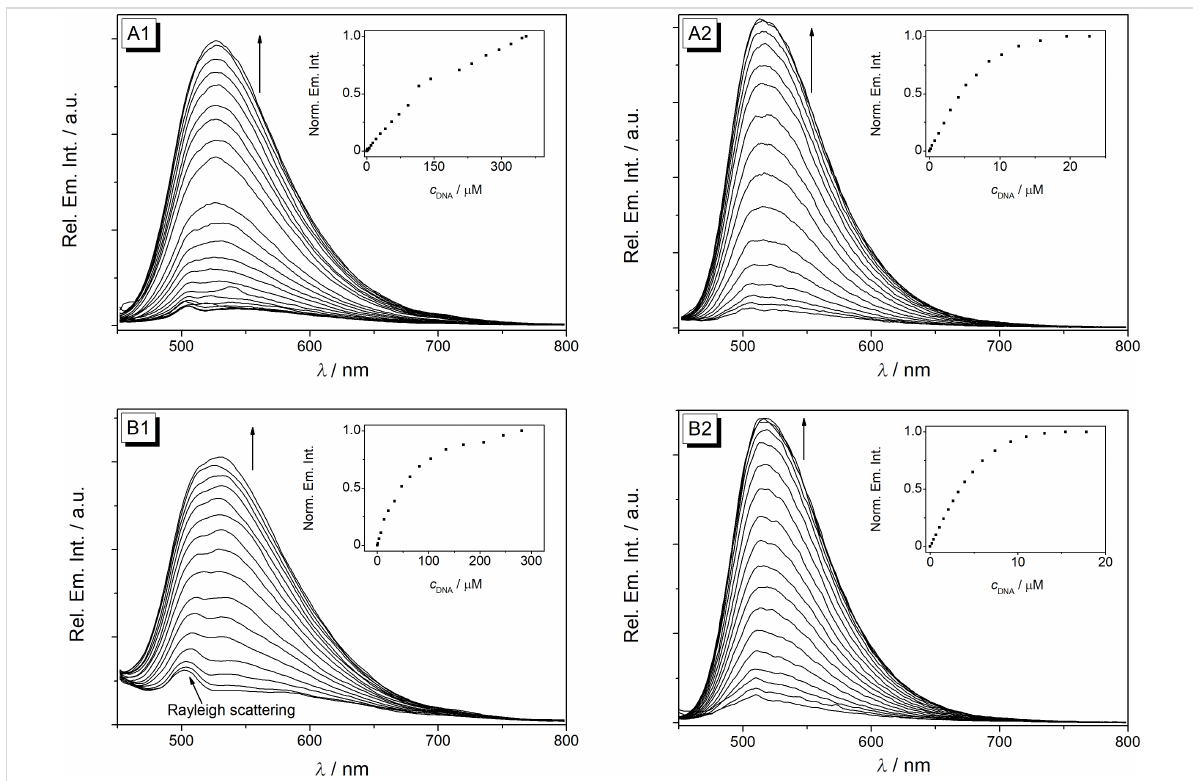
Figure 4: Fluorimetric titration of 5a (A) and 5d (B, c Ligand = 20 μ M) with ct DNA (1) in BPE buffer ( c Na+ = 16 mM, pH 7.0, with 5% v/v DMSO) and with 22AG (2) in K-phosphate buffer ( c K+ = 110 mM, pH 7.0, with 5% v/v DMSO); λ ex = 430 nm. The arrows indicate the changes of the emission bands upon addition of DNA. Insets: Plots of the relative fluorescence intensity versus c DNA (in base pairs).